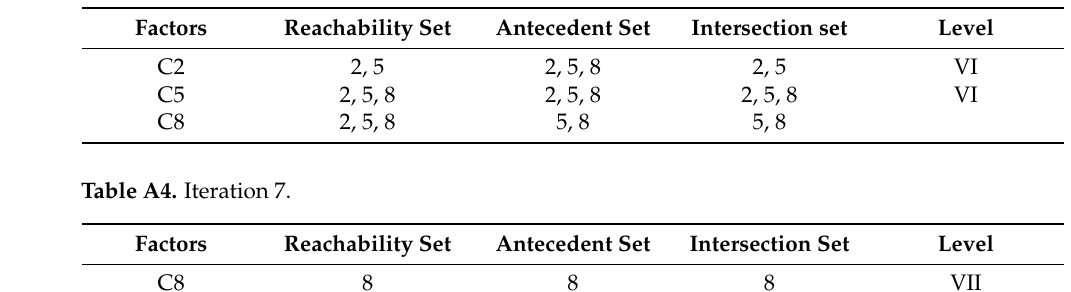
Table A3. Iteration 6.